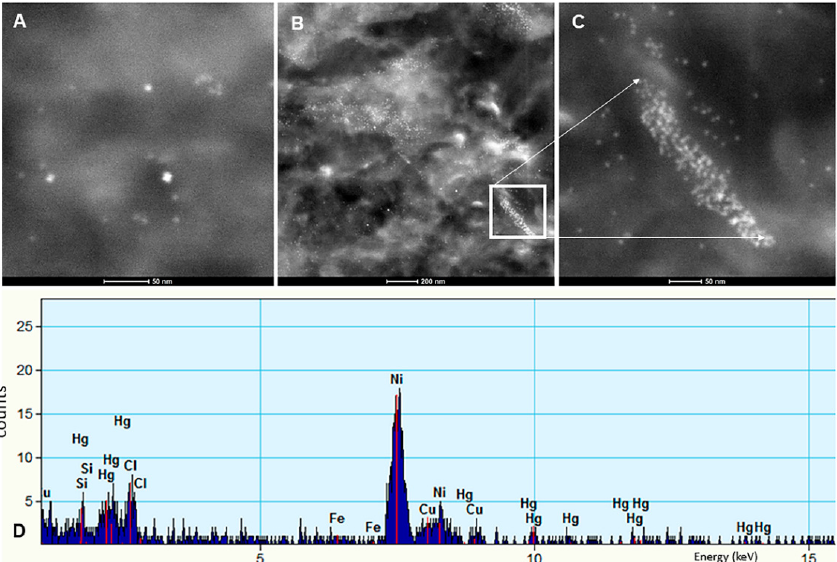
Figure 7. NP characterization by TEM and EDX in substantia nigrae. Different sizes and shapes of NPs are seen through the SNpc cells and the neuropil. ( A ). Three HgNPs are identified, ( B ). The predominant NPs are Fe and Hg in this sample. ( C ). In a close-up of a finger-like macrophage extension towards the neuropil (from square in B), we documented the accumulation of predominantly FeNPs. ( D ). Hg is the main element detected in another SNpc sample from a teen. Ni reflect the TEM support